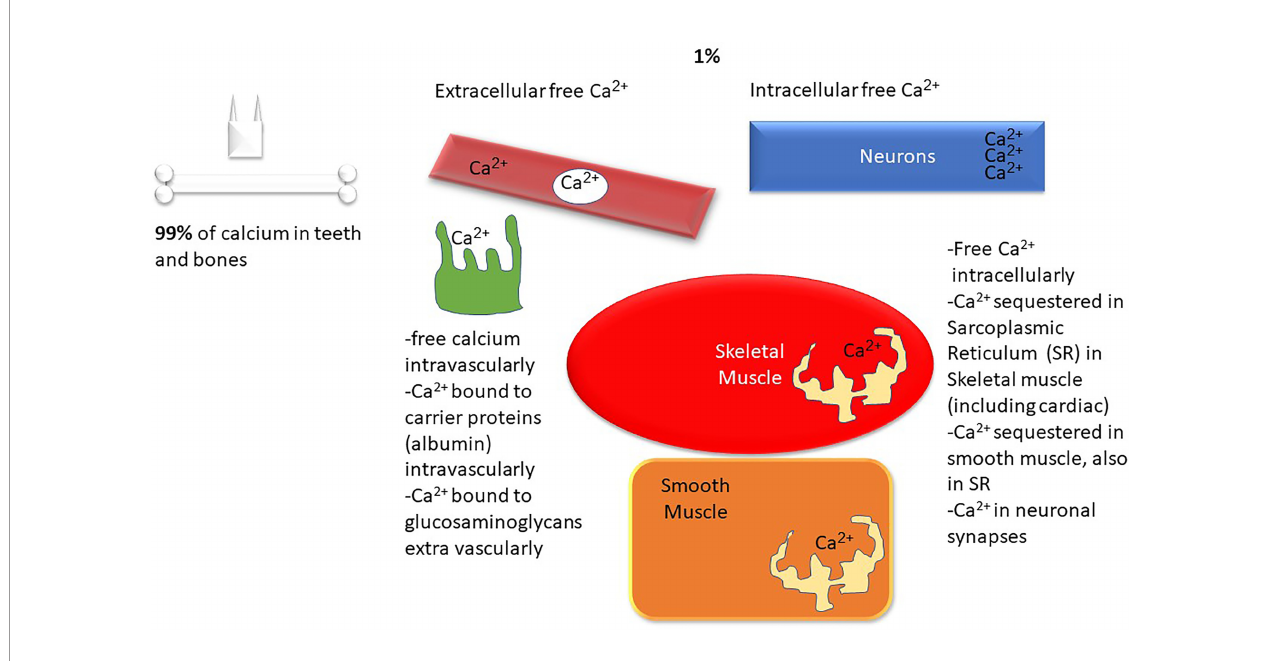
FIGURE 1 | Calcium metabolism overview: Ca 2+ , calcium; SR, sarcoplasmic reticulum.